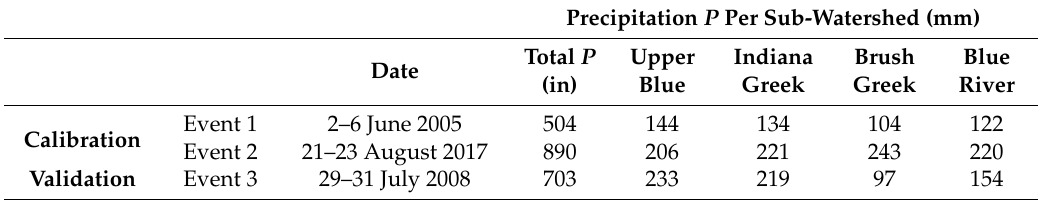
Figure 4. The watershed model created by HEC-GeoHMS, and Hydrological soil group based on SSURGO data. Table 2. Total precipitation (mm) based on radar rainfall obtained from KC station.